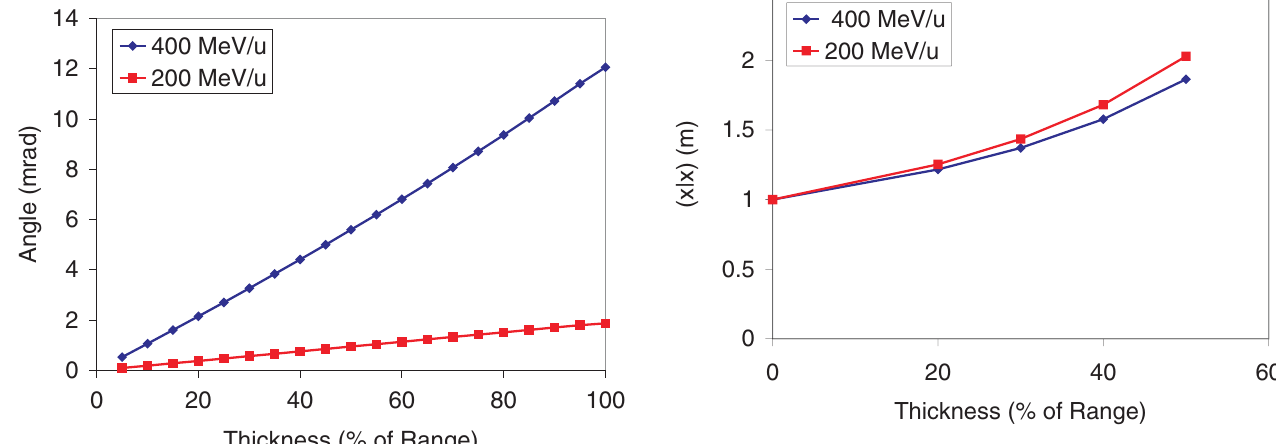
FIG. 5. (Color) Optimal angle needed to maintain linear achro- maticity for the case of a 132 Sn beam at various wedge thick- nesses and two different energies.